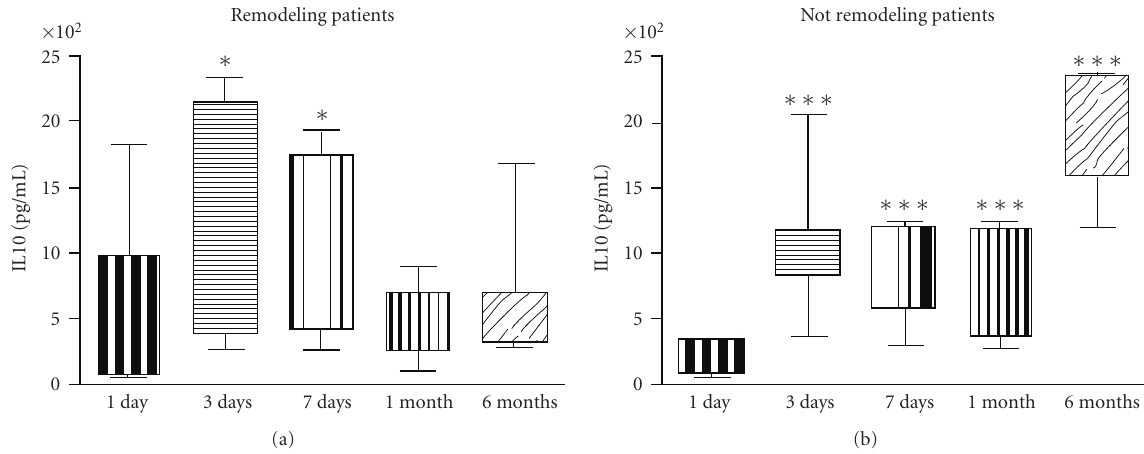
Figure 6: In patients developing left ventricular remodeling after myocardial infarction ( n = 20) lymphomonocyte production of IL10 in response to LPS was increased on day 3 and day 7 after reperfusion in comparison with day 1 ( ∗ P < . 05). In patients not developing left ventricular remodeling after myocardial infarction ( n = 20) lymphomonocyte production of IL10 in response to LPS was increased on day 3, on day 7, 1 month, and 6 months after reperfusion in comparison with day 1 ( ∗∗∗ P < .